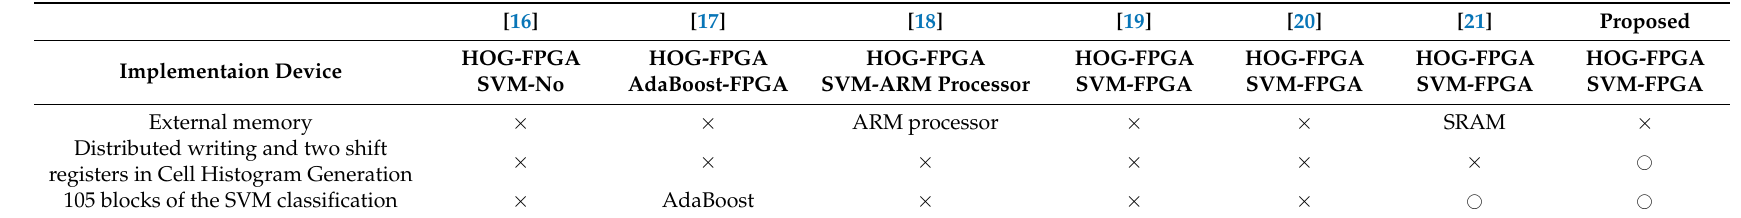
Table 2. Comparing this study’s implementation methods with other previous works.